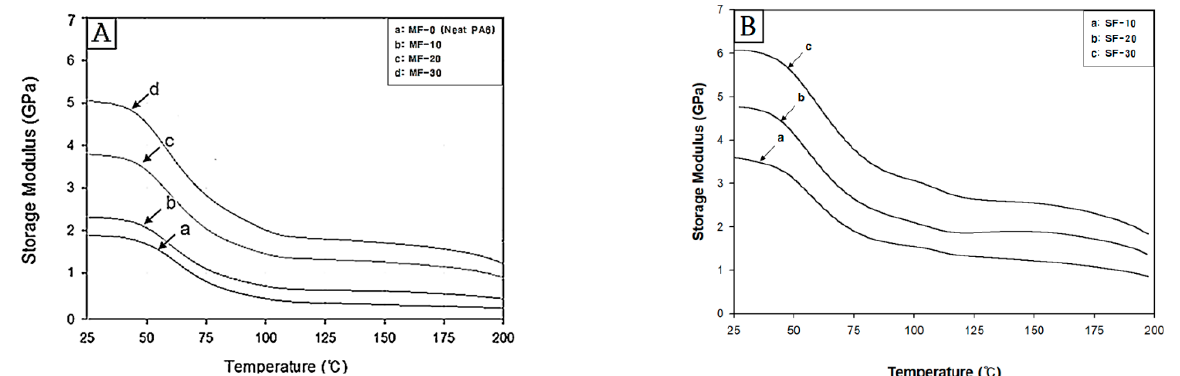
9 of 15 Figure 6. HDT values of the MF-NiCF/PA6 and SF-NiCF/PA6 composites with various NiCF con- tents. 3.4. Storage Modulus Figure 7 shows the variation in the storage modulus measured with the neat PA6 and NiCF/PA6 composites, depending on the NiCF content and the fiber-feeding method. The storage modulus rapidly decreased with the increasing temperature, particularly above about 40 °C due to the glass transition behavior of neat PA6 and the PA6 matrix of the composite. The storage modulus of the neat PA6 at 25 °C was about 1.9 GPa. It was grad- ually increased by increasing the NiCF content, indicating the highest modulus of 6.1 GPa with the 30 wt% SF-NiCF/PA6 composite and the highest modulus of 5.1 GPa with the 30 wt% MF-NiCF/PA6 composite, indicating a 19% improvement by side-feeding of NiCF. The increased improvement in the SF-NiCF/PA6 composite can be explained by the increased reinforcing effect due to the length distribution and the aspect ratio of NiCF in the composite, as described earlier. It may be said that the PA6 matrix surrounding the